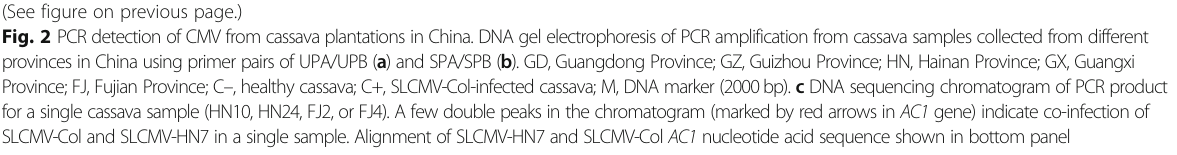
Table 1 Number of different SLCMV strains-infected cassavas SLCMV-HN7 simple infected SLCMV-Col simple infected Co-infected Total samples GD 0